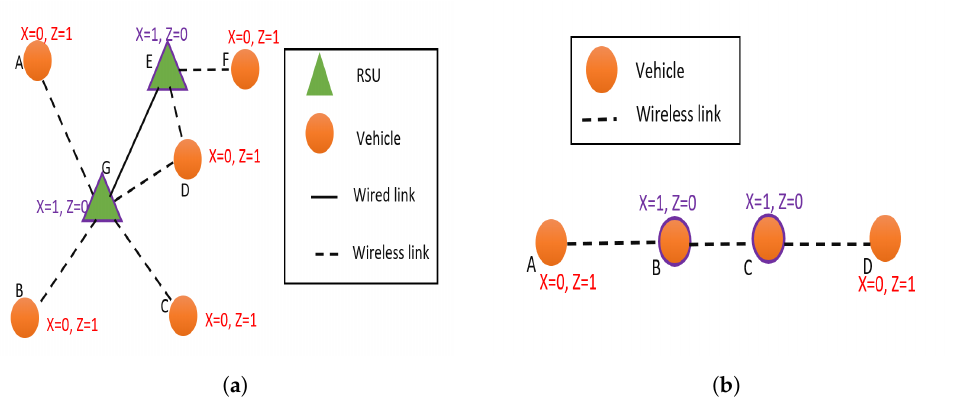
Figure 4. Network topologies showing the solution of the optimizer for data collection in Hybrid architecture. ( a ) Ad hoc topology; ( b ) Chain